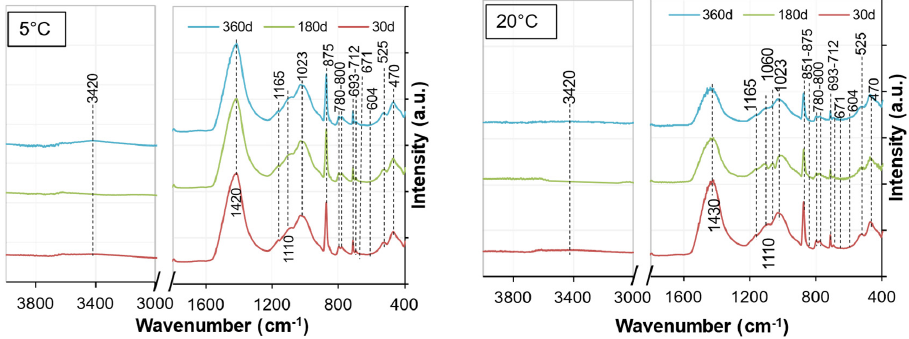
Figure A9. FTIR results of S + F + W1.